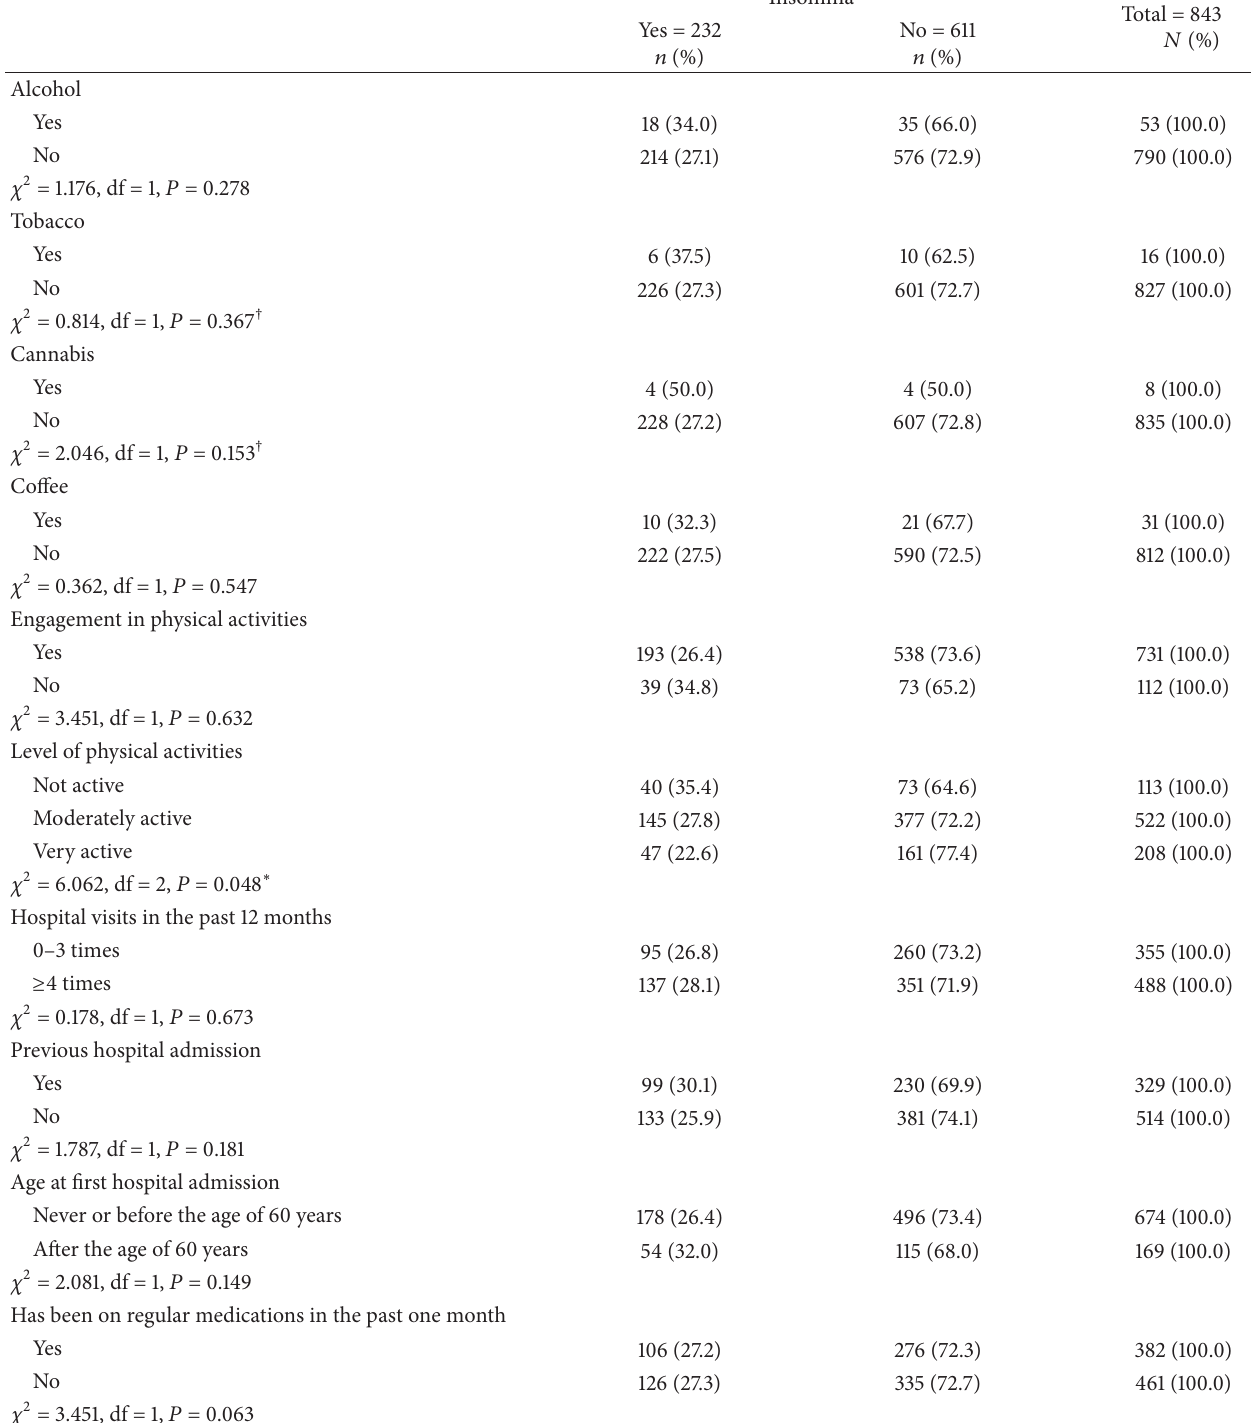
Table 3: Lifestyle habits and hospital care utilization by the prevalence of